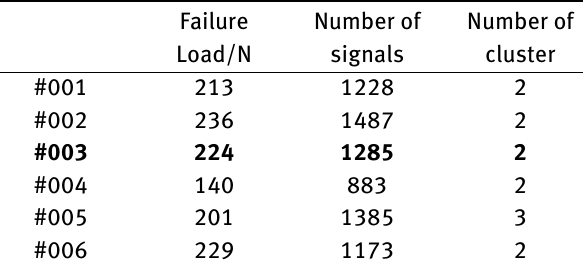
Table 4: List and result of fiber bundle tensile tests